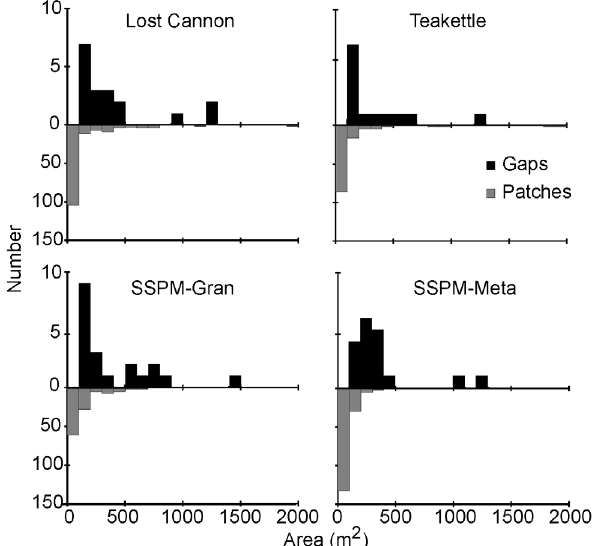
Figure 9. Forest patch and gap area distributions in four old- growth Jeffrey pine-mixed conifer forests. Areas were estimated from four ha stem maps. Not shown is the largest patch at Teakettle with an area of 2589 m 2 .